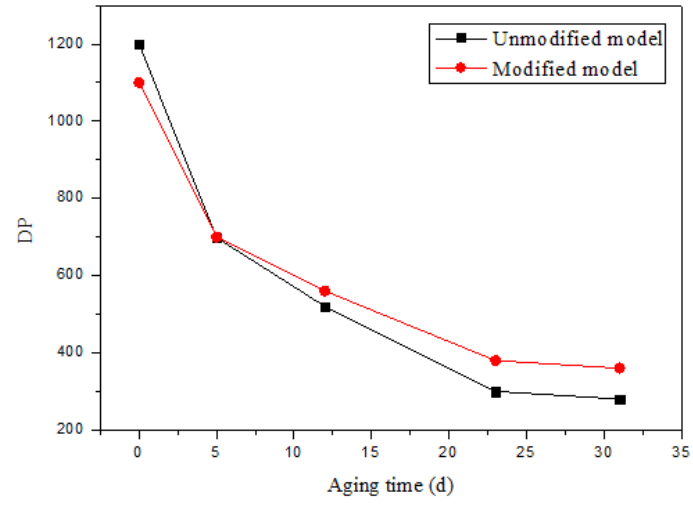
Figure 39. Variation of polymerization degree (DP) of insulation paper with ageing time.